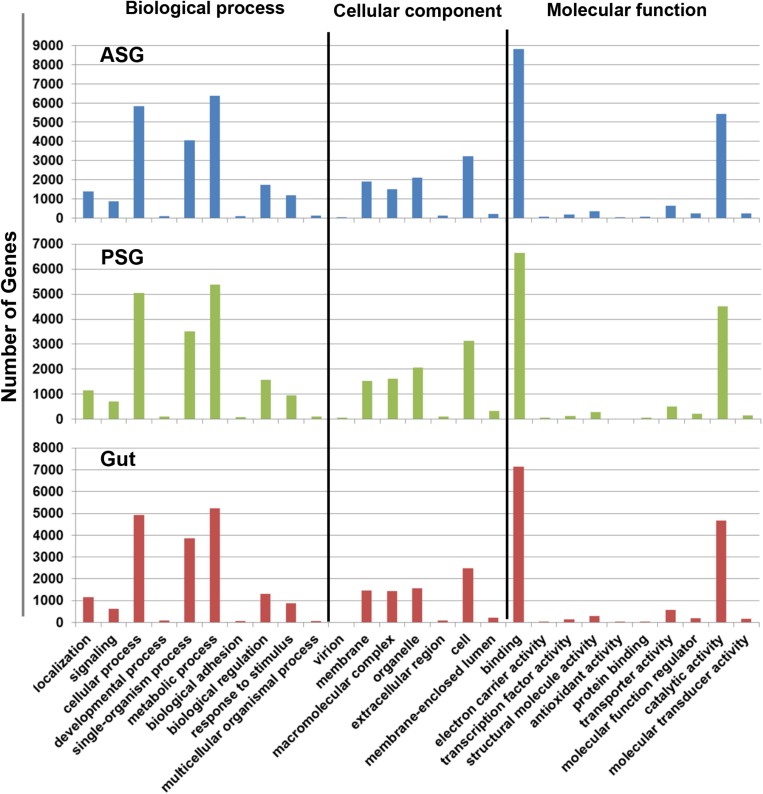
Gene ontology terms assigned to gene sequences involved in biological process, cellular component, and molecular function. Similar numbers of transcripts were assigned to each function for the ASG, PSG, and gut transcriptomes.